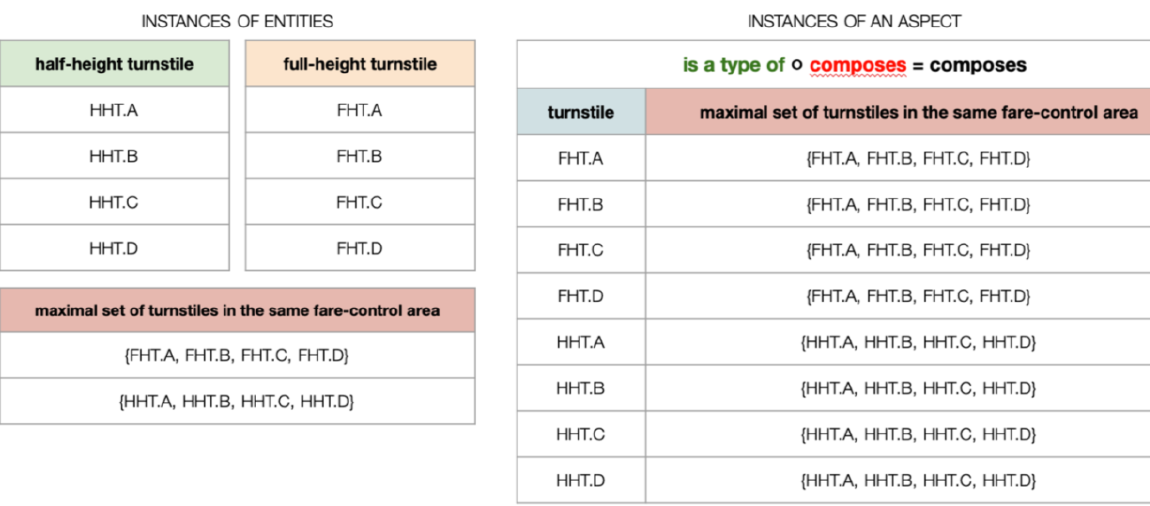
Figure 3. Instances of turnstile-related entities and of the aspect “composes”. The two instances of “maximal set of turnstiles in the same fare-control area” correspond to the two separated fare-control areas in the station. Notice that the composition of “is a type of” and “composes” returns the aspect “composes” (which confirms the definition of “is a type of” as a